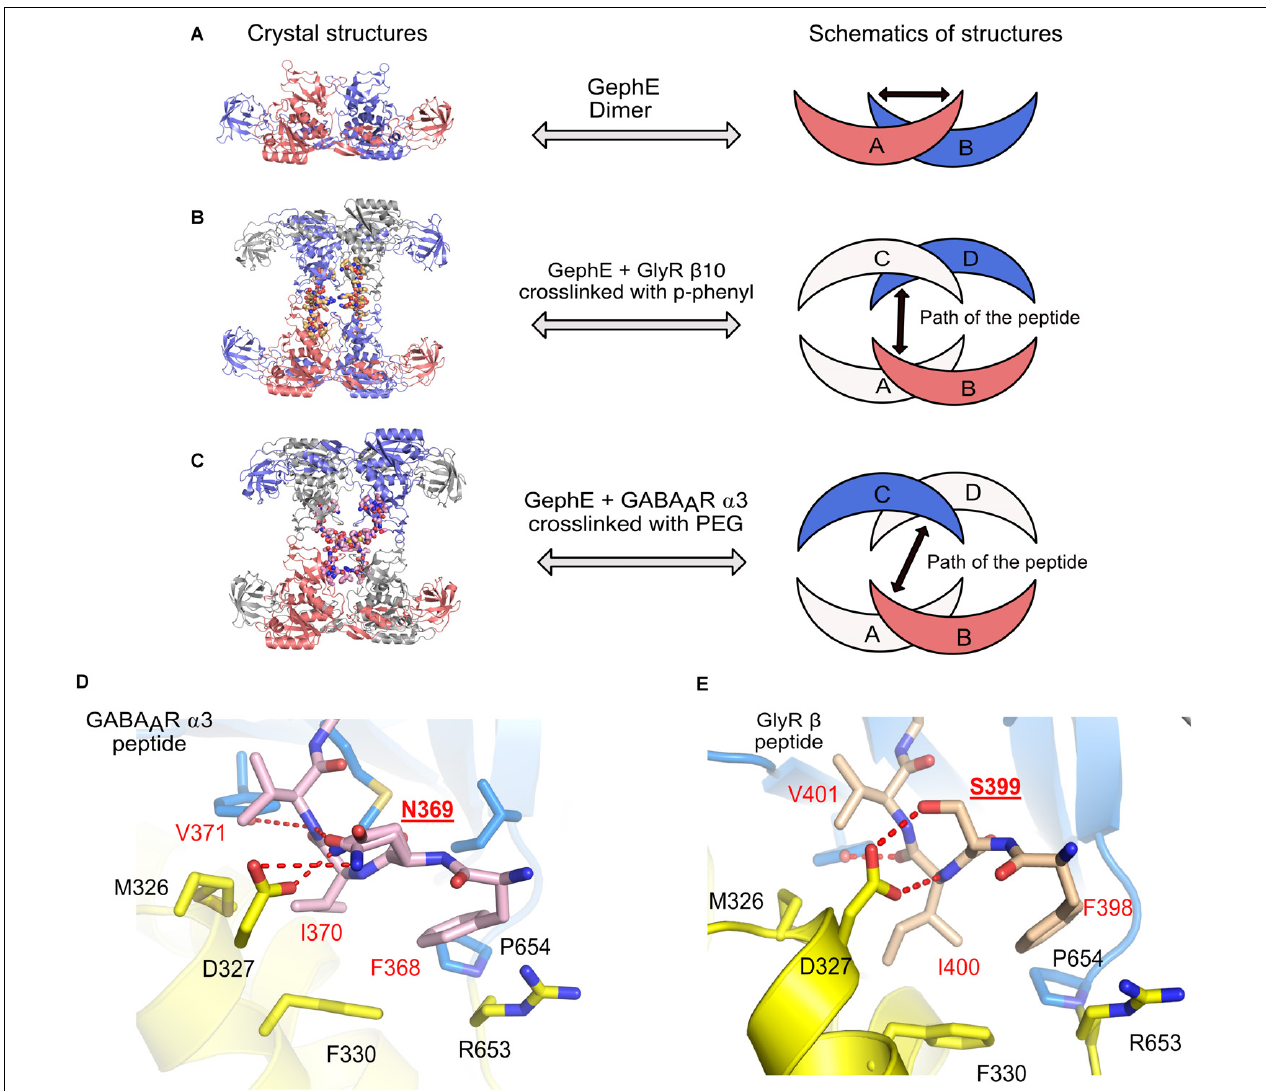
FIGURE 8 | Domain swapped crystal structures of GephE-receptor derived peptide complexes. (A) Crystal structure of the GephE dimer in the apo form. Crystal structures of domain swapped GephE-peptide complexes determined in the presence of high affinity dimeric peptide derived from either GlyR β ( B , PDB: 4U91) or GABA A R α 3 ( C , PDB: 4U90) subunits. The peptide takes a straight trajectory in case of the GlyR- β peptide in contrast to the GABA A R α 3 peptide which adopts a cross trajectory to connect two GephE monomers. (D,E) Enlarged views of the N-terminal region of the GABA A R α 3 and GlyR- β core binding motifs. Please note that in the case of the GABA A R α 3 peptide (D) Asn369 (underlined label) is forced to exhibit dual conformations of its side chain to match the hydrogen bonding potentials of its partners, in contrast, a single conformation of Ser399 in GlyR- β effectively stabilizes the GephE-GlyR